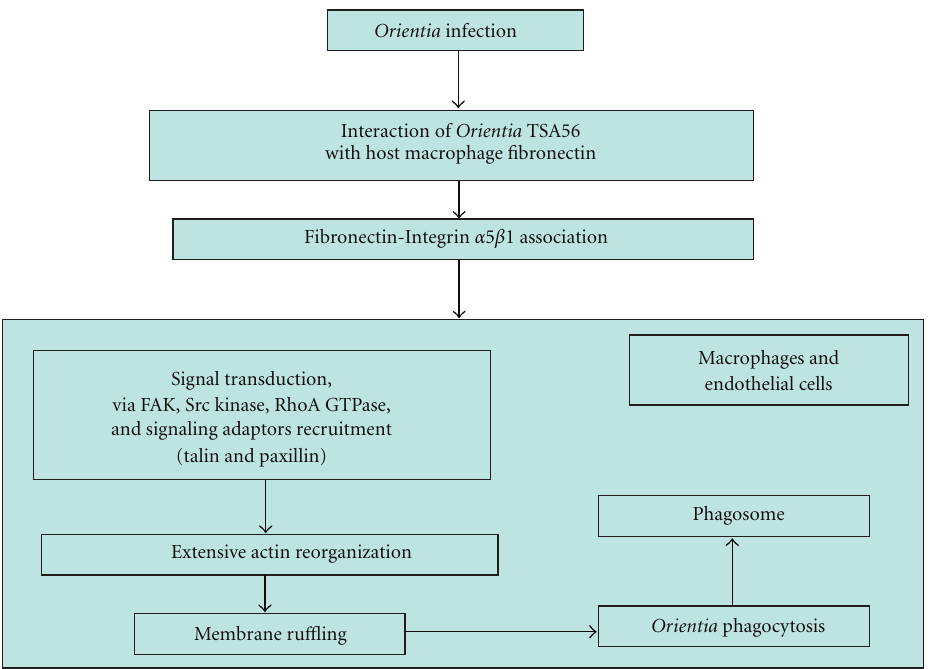
Figure 6: Orientia macrophages and endothelial cells